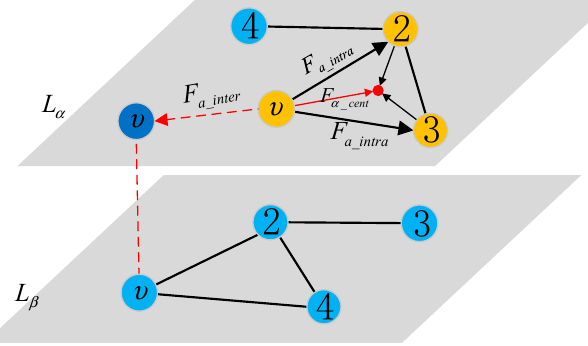
Figure 5. Schematic diagram of multi-force directed model.